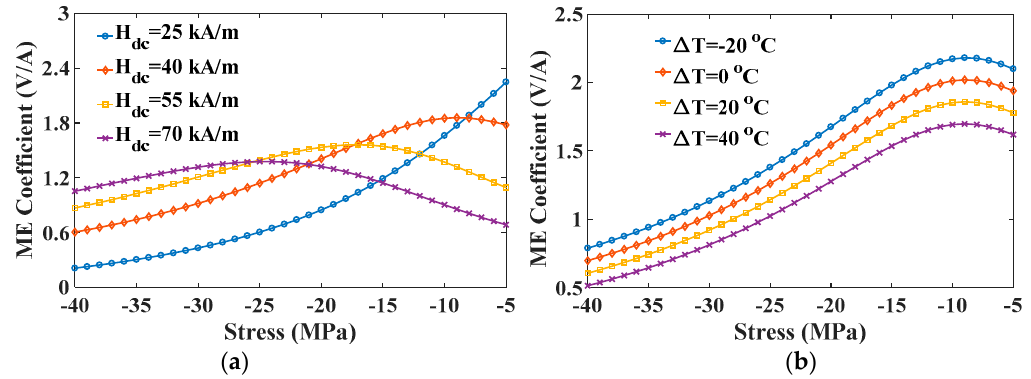
Figure 13. The ME coefficient varied with stress under different ( a ) magnetic fields and ( b ) temperatures.